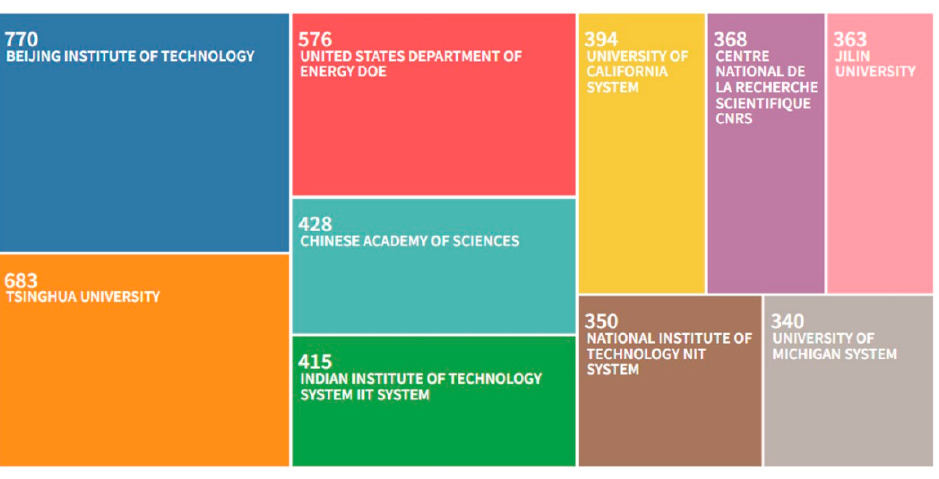
Figure 4. Network visualization of the most productive countries in VEs research output.